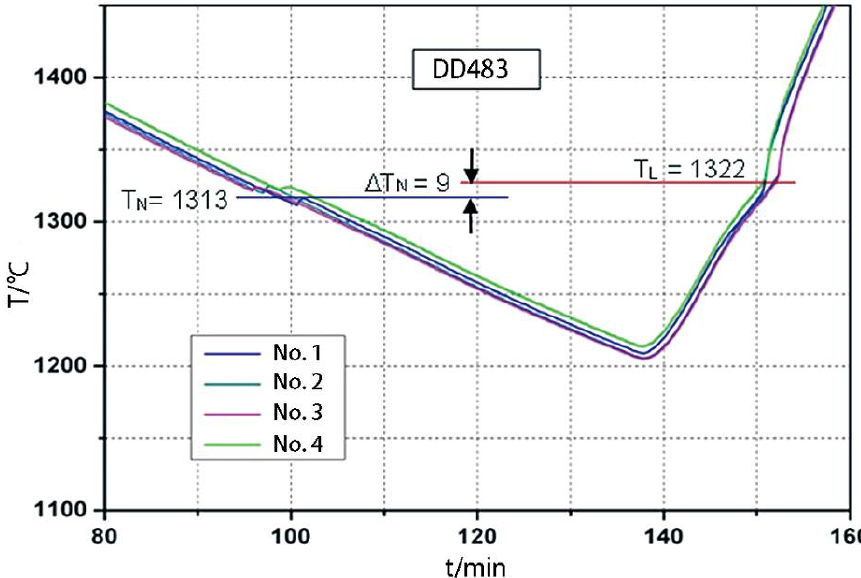
Figure 5. Temperature evolution of four DD483 samples (No. 1 to No. 4) recorded during the first cooling–heating cycle.